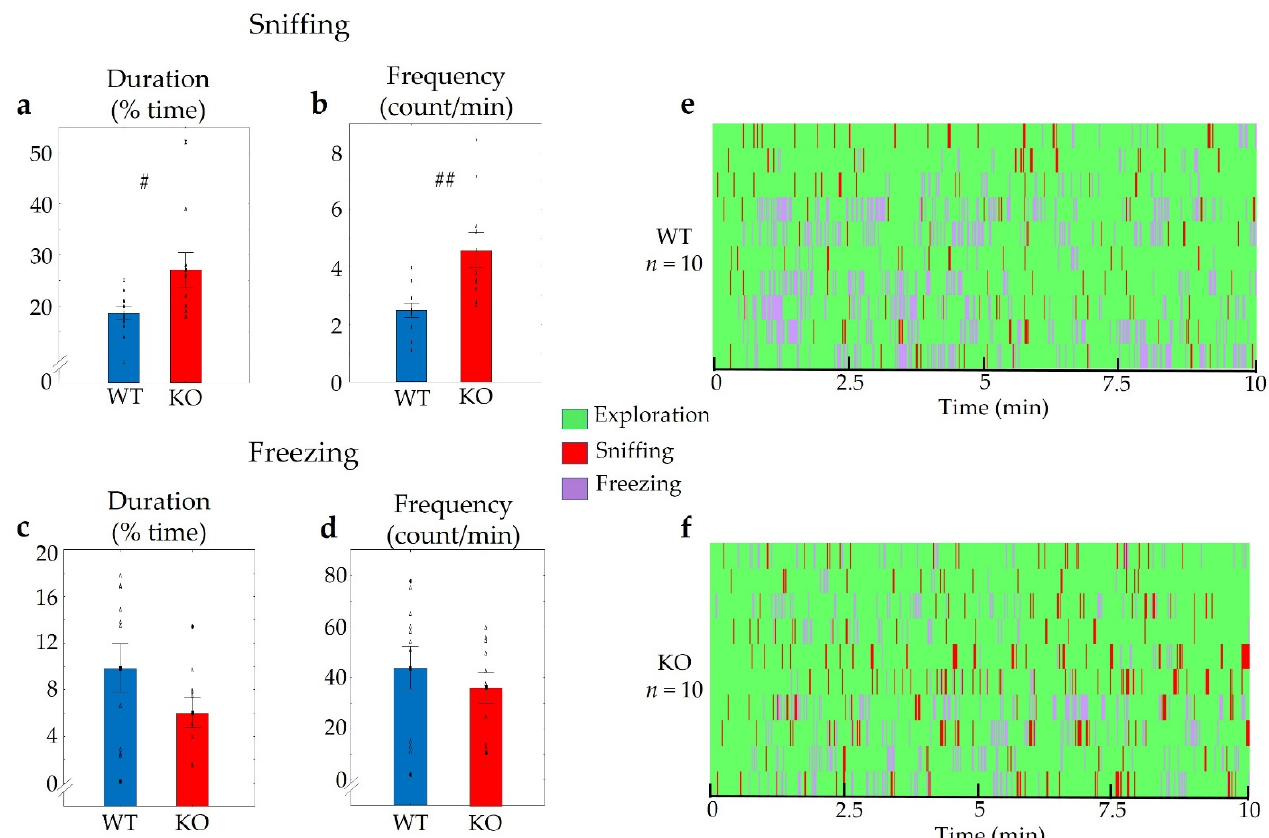
Figure 5. Behavioural differences in Trpa1 WT and KO mice triggered by the major component of cat odour, valeric acid. Significant differences were detected in the duration ( a ) and frequency ( b ) of sniffing the odour holder between the two groups. However, differences in innate fear (freezing) were not present in this trial ( c , d ). Individual values are represented on a Gantt diagram ( e , f ). n = 10 in both (WT and KO) groups, the symbol # shows a significant difference between the two genotypes, in cases with # p < 0.05, and ## p < 0.01. Blank triangles represent individual values while dark spots show outliers (characterized by a higher or lower value than mean ± 2 standard deviation (SD)).